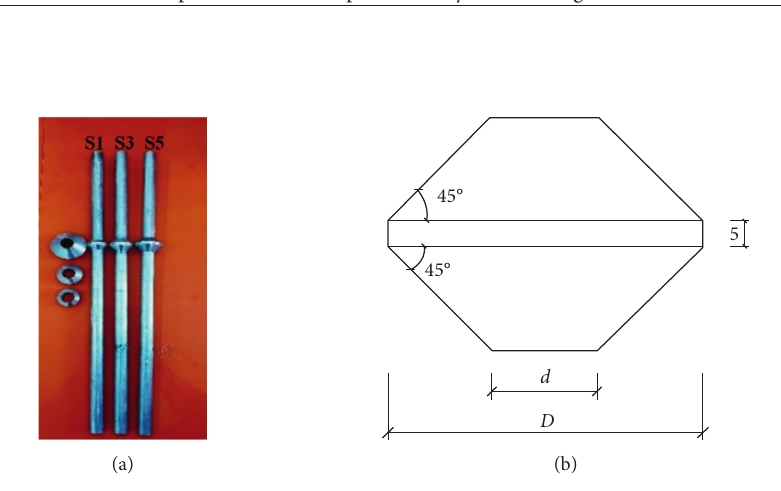
Figure 4: The model of the squeezed branch pile. (a) Model pile. (b) Branch